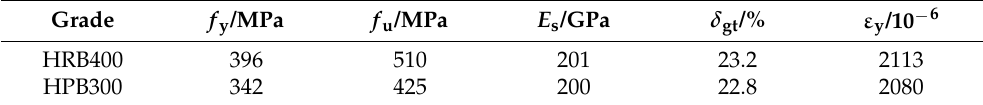
Table 2. Mechanical properties of steel bars.